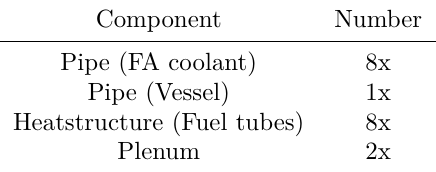
Table 1. List of RELAP5 components utilized in the single assembly VR-1